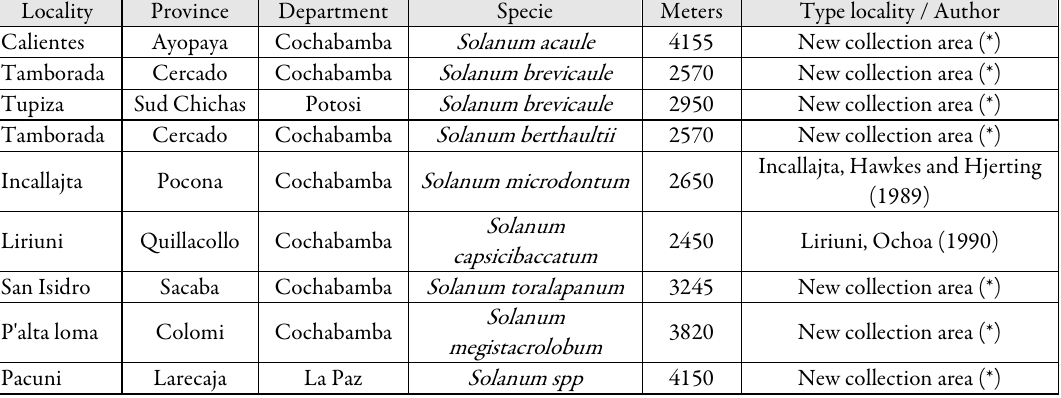
Table 1. Potato wild species samples collection from different parts of the Andean region of Bolivia